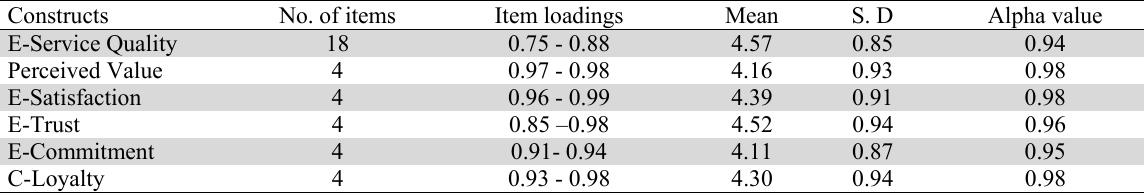
The Measures and the Psychometric